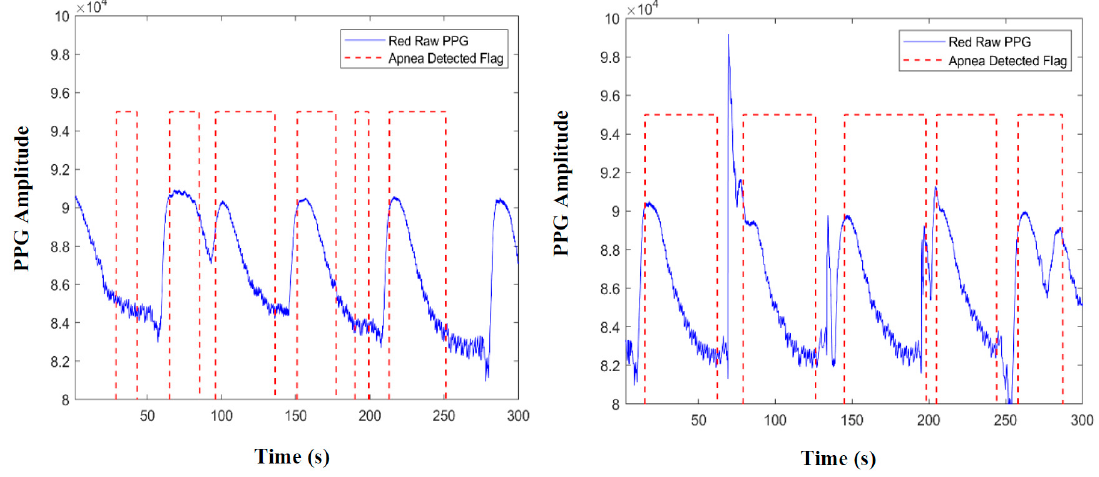
Figure 5. Double apnea detection prevented by the 30 s of overlap.